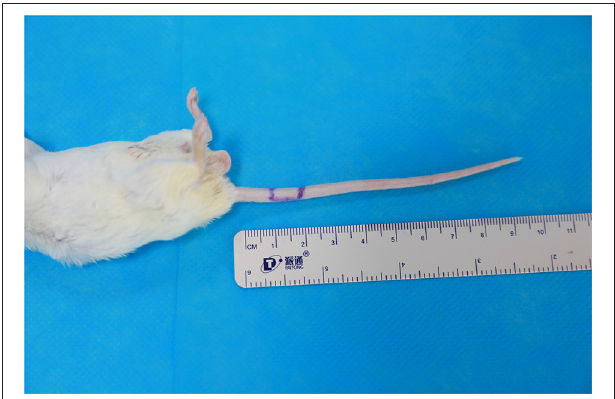
FIGURE 1 | A ⊔ -shaped incision was made one centimeter from the root of the mouse tail.